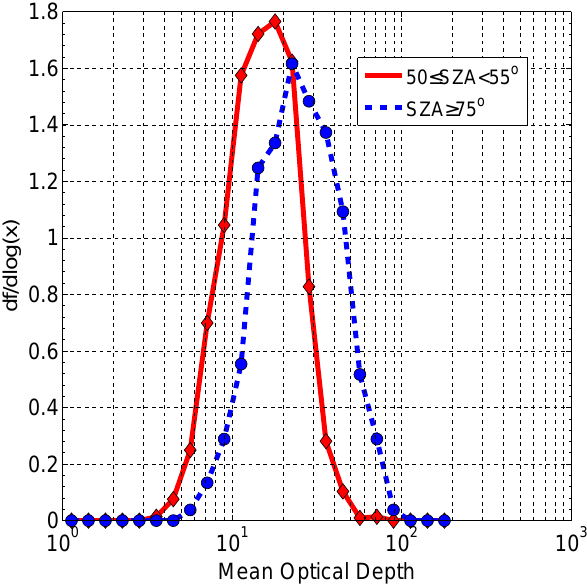
Figure 6. PDFs of optical depth ( τ ) for low viewing zenith angles (VZA ≤ 41 . 4) and for different solar zenith angles (SZA or θ 0 , see the legend). Other data restrictions are described in the text. Proba- bilities are normalized by the bin widths in log 10